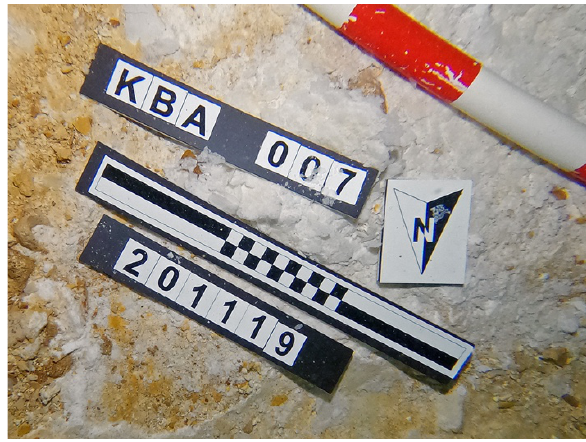
Figure 12 . Example of a legend zone including magnetic bases, magnetized alphanumerical tiles with the Unique Identifier (UID), a North arrow, the date, and two scales (CINDAQ)